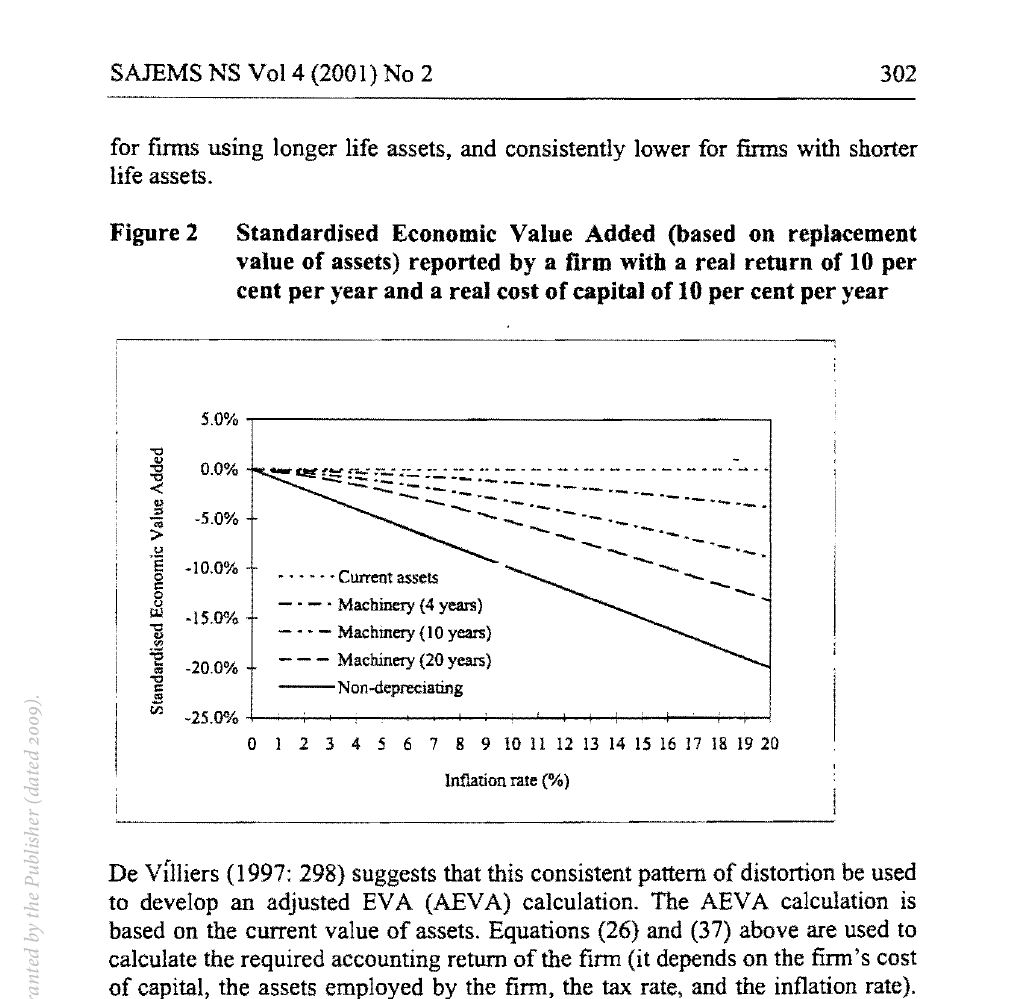
Figure 2 Standardised Economic Value Added (based on replacement value of assets) reported by a firm with a real return of 10 per cent per year and a real cost of capital of 10 per cent per